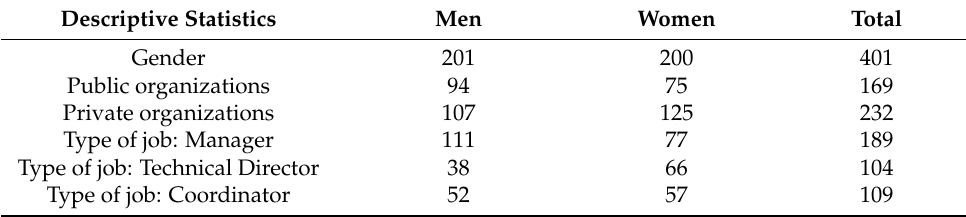
Table 2. Study sample.